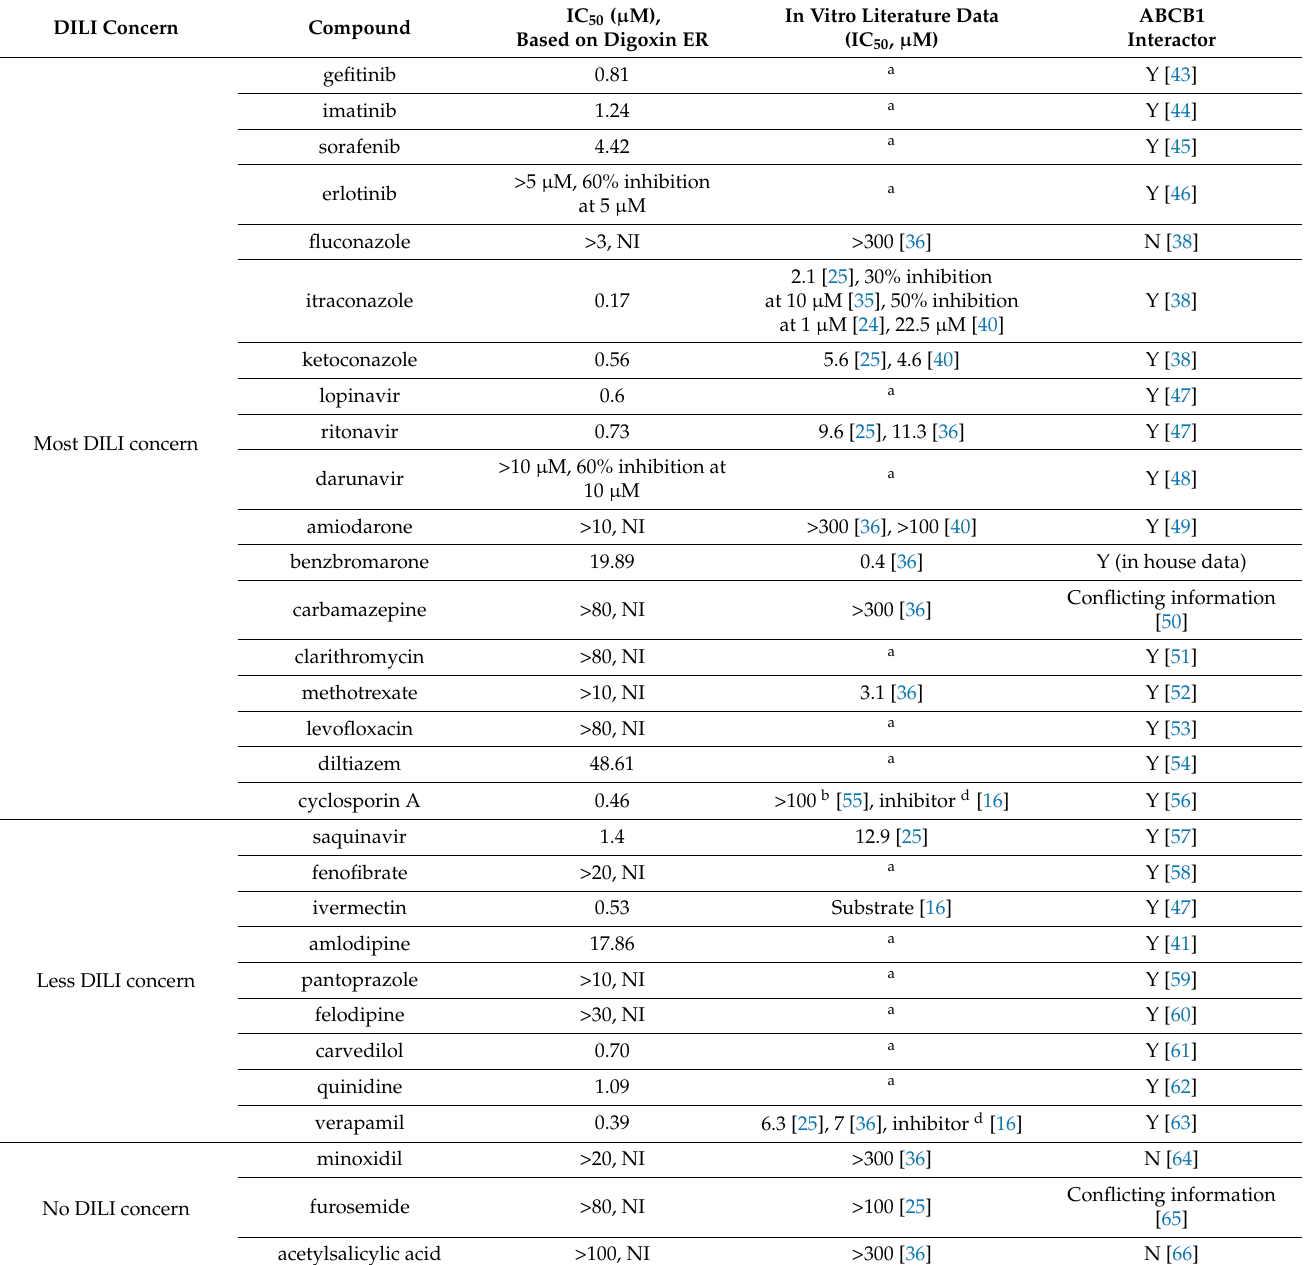
Table 1. Tested compounds with ABCB4 inhibition activities and with ABCB1 interaction